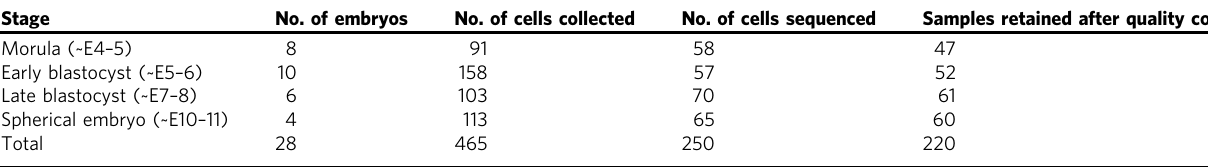
Table 1 Samples of embryos